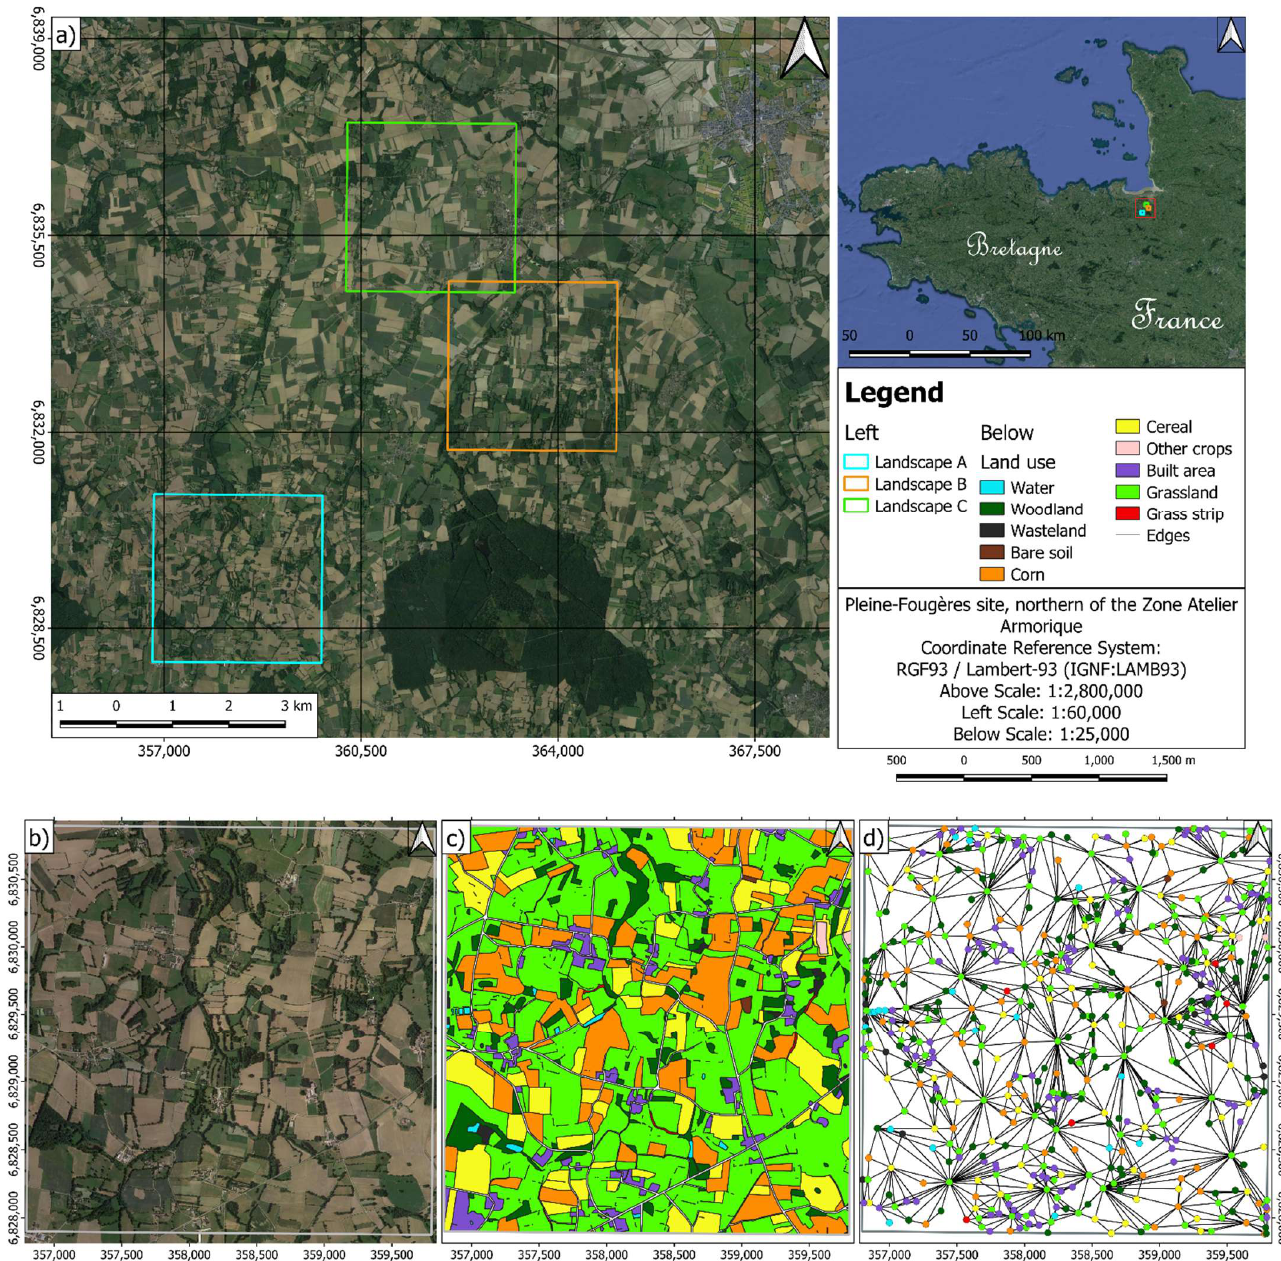
Figure 1. The Zone Atelier Armorique. ( a ) The locations of the three study landscapes of low (A), medium (B), and high (C) agricultural intensity. An example of landscape A shown as ( b ) a red–green–blue (RGB) image, ( c ) a discrete land-use map, and ( d ) a graph of interactions between patches. Note that nodes in ( d ) are represented by the same color categories as in ( c ). The three images correspond to the same year (2010).